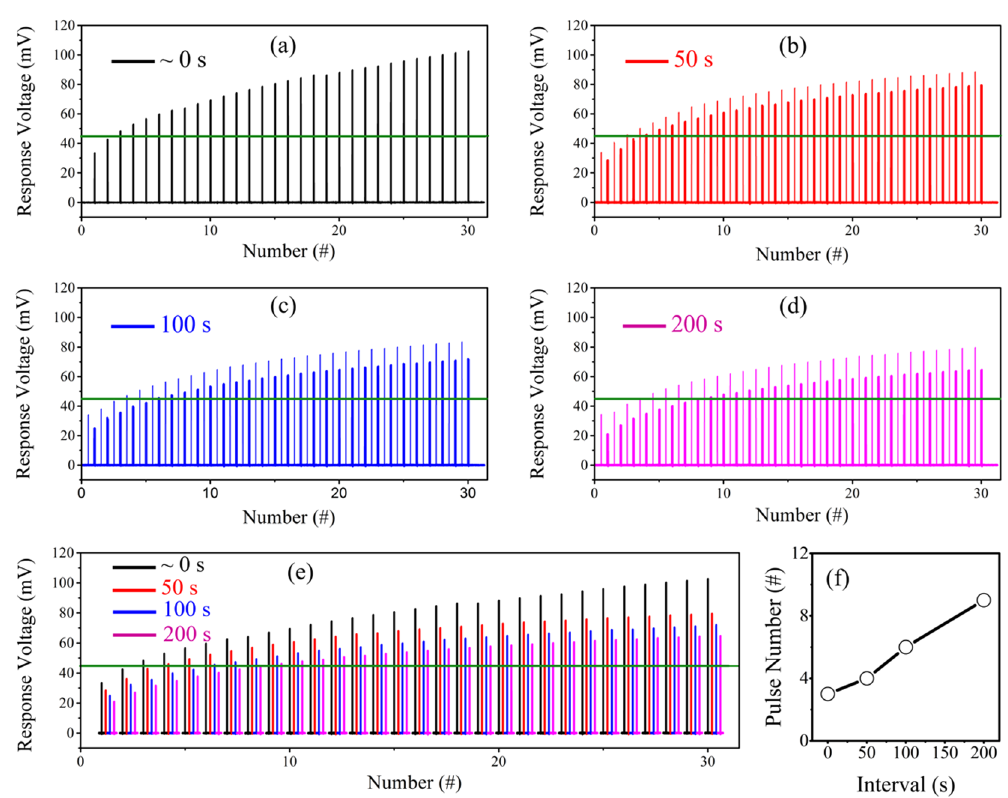
Figure 5. Effect of time interval between individual training trials on acquisition. The time intervals are approximately 0 s, 50 s, 100 s and 200 s in ( a ) to ( d ), respectively. The CS-US temporal relation is fixed to 4 ms. The coarse lines are the response voltage tested after the corresponding time interval. The fine lines are the voltage checked immediately after the stimuli. ( e ) Comparison of the response voltage with different time intervals in ( a ) to ( d ). Only coarse lines are compiled. ( f ) Necessary number of training trials for acquisition with different time